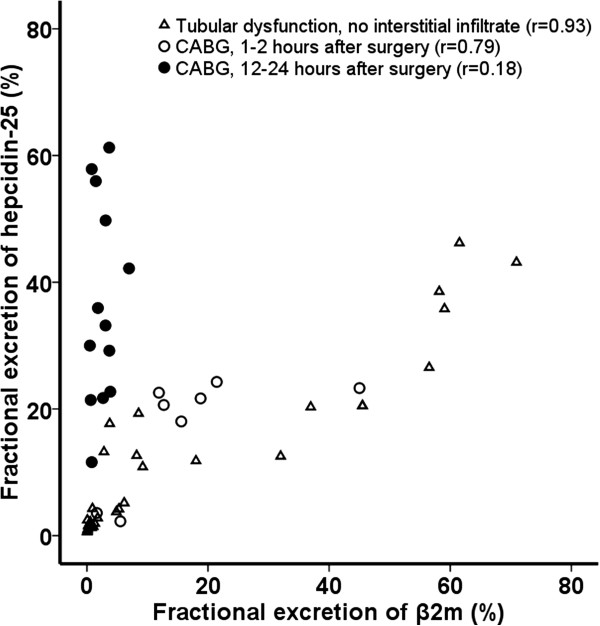
Correlation between fractional excretion (FE) of hepcidin-25 and β2-microglobulin (β2m) in patients with renal disease without a tubulointerstitial infiltrate (n = 30, triangles), and in patients at 1–2 hours (n = 8, white circles) and 12–24 hours (n = 13, black circles) after cardiopulmonary bypass grafting (CABG). FE of hepcidin correlates with FE of β2m, indicating tubular uptake of hepcidin. However, FE of hepcidin increased relatively more in patients 12–24 hours after CABG, suggesting local production in the kidney.